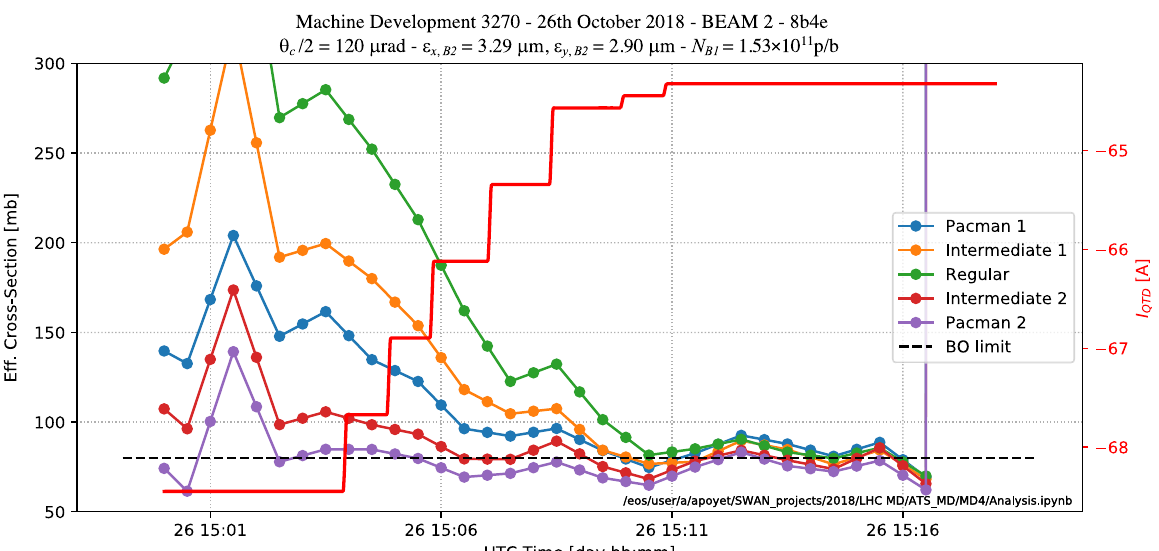
FIG. 10. 2018 ATS MD: 8b4e bunch trains in collision at β (cid:1) various classes of bunches of Beam 1 (top) and Beam 2 (bottom) after a tune scan along the diagonal, and with the octupoles pushed to their maximum current of 550 A with negative